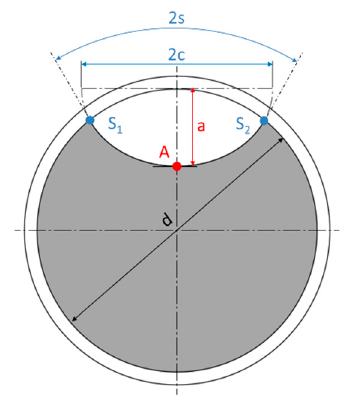
Figure 5. Nomenclature of the semi-elliptical crack.